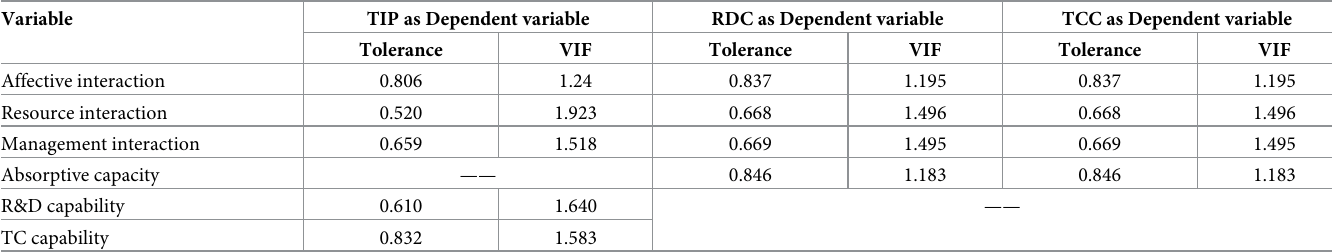
Table 3. Assessment of multicollinearity.